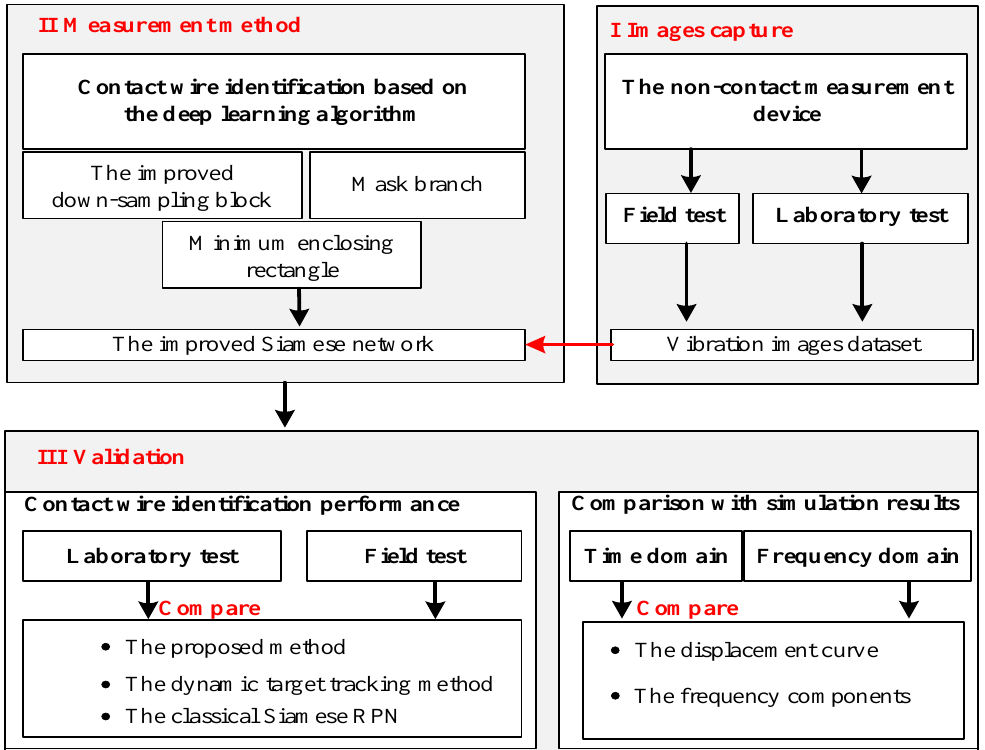
Figure 2. Main ideas and their relations in this paper.